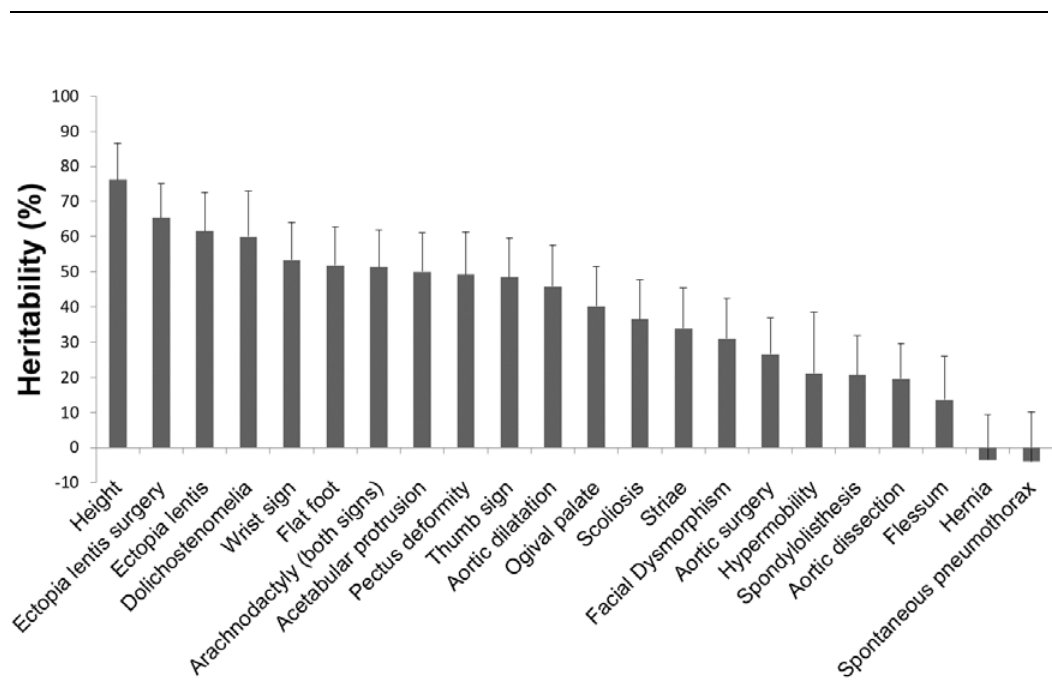
Figure 3. Heritability (H 2 ) estimates of MFS clinical features. Heritability estimates were based on familial aggregation of clinical features among first-degree relatives. Error bars show standard deviations (SDs) and rely on asymptotic SDs of parent–offspring and siblings correlations provided by S.A.G.E. (Statistical Analysis for Genetic Epidemiology).